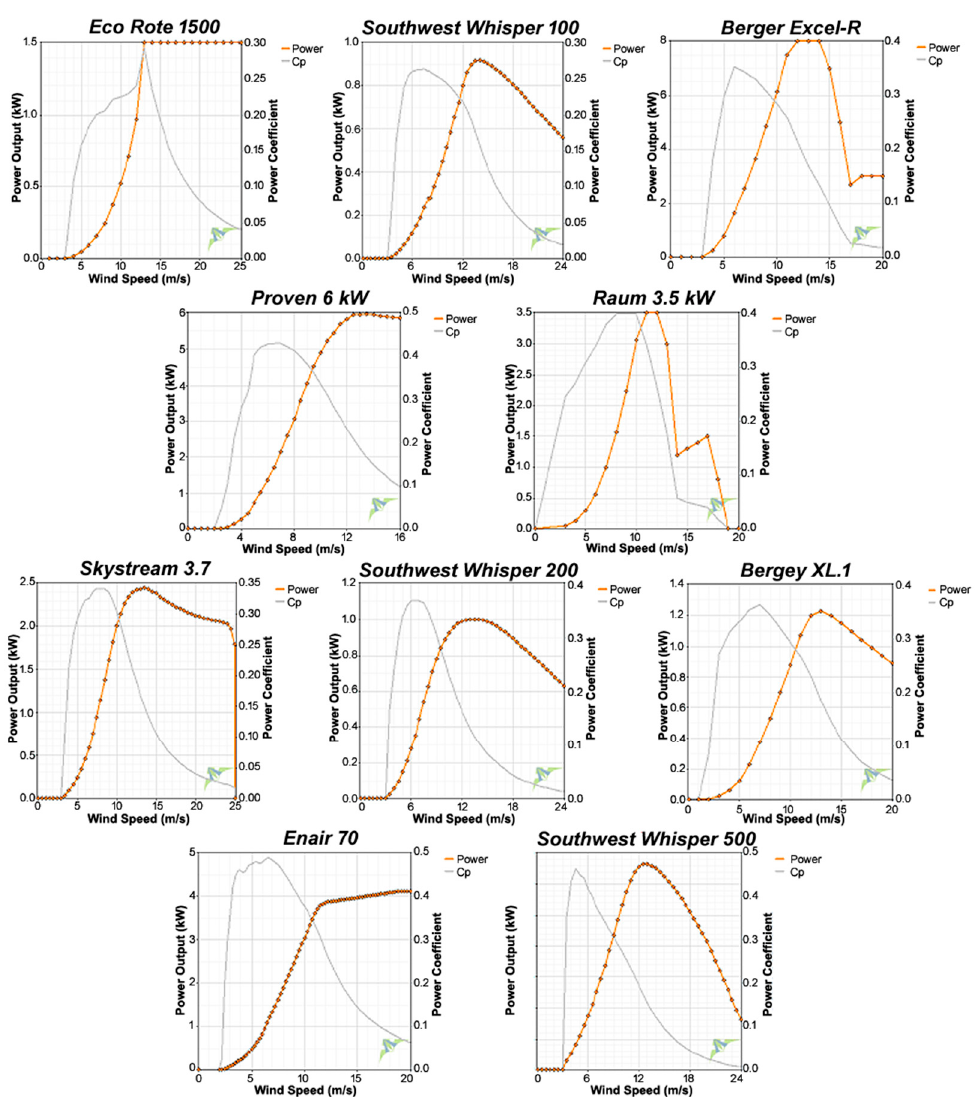
Figure 19. Power output and power coefficient curves for the wind turbines selected for compara- tive analysis.